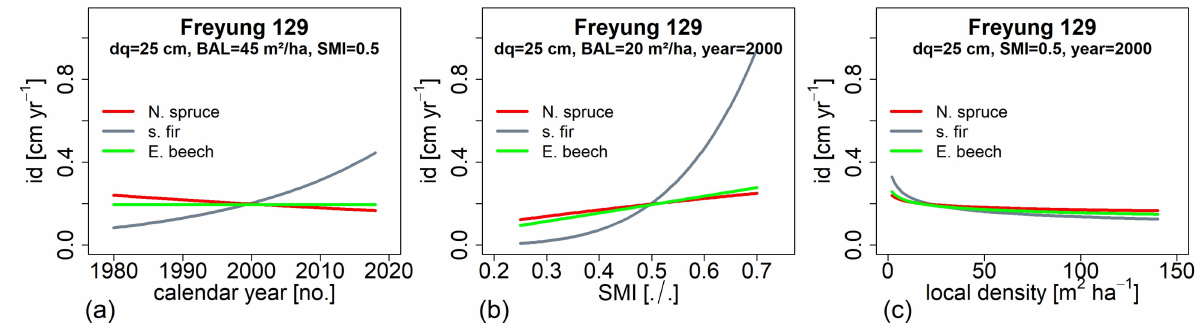
Figure 9. Stem diameter growth of Norway spruce, silver fir, and European beech depending on ( a ) calendar year, ( b ) Soil Moisture Index, and ( c ) local stand density (BAL) according to Model 5. For showing the three dependencies the other variables in the model were kept constant and set to representative mean values (see heading of each